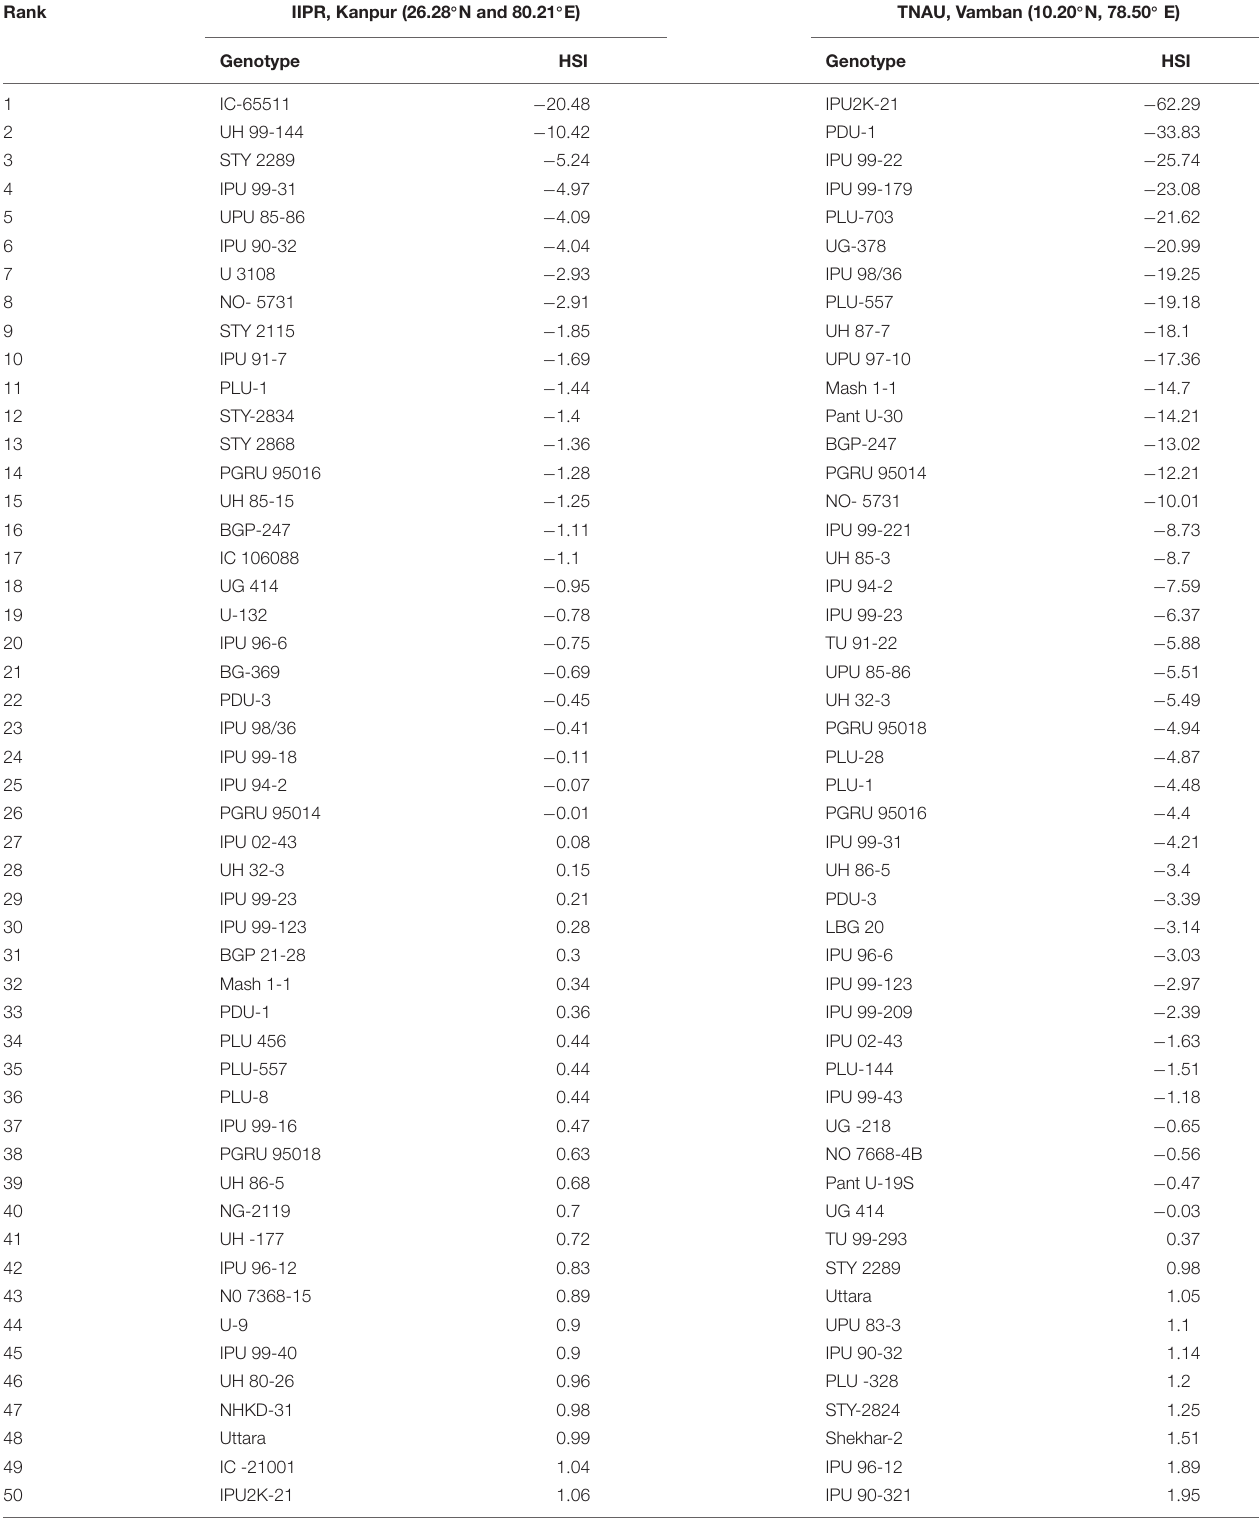
TABLE 3 | Heat susceptibility index (HSI) of 97 urdbean genotypes under IIPR, Kanpur and TNAU, Vamban condition. Rank IIPR, Kanpur (26.28 ◦ N and 80.21 ◦